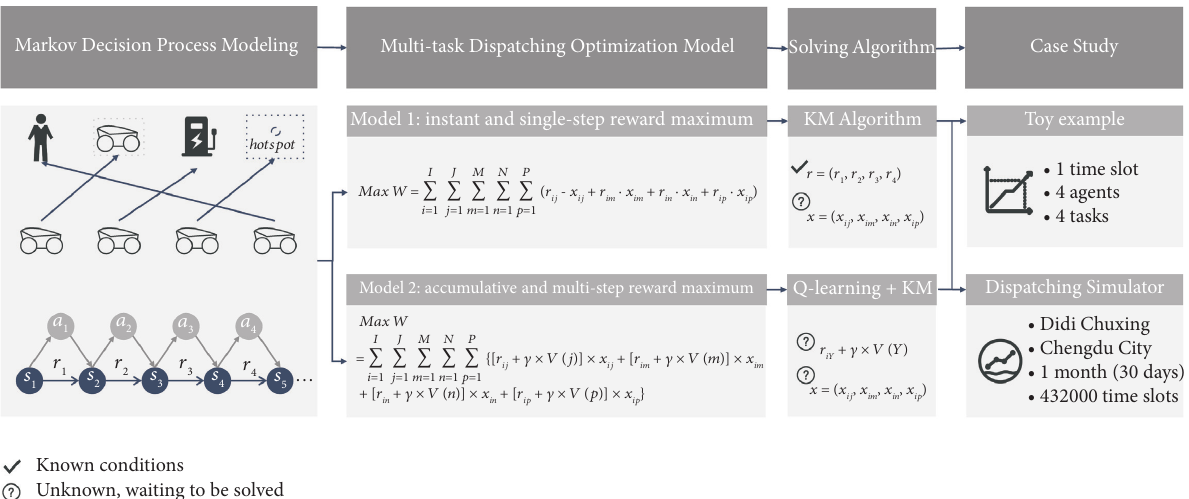
Figure 1: Method and analyzing